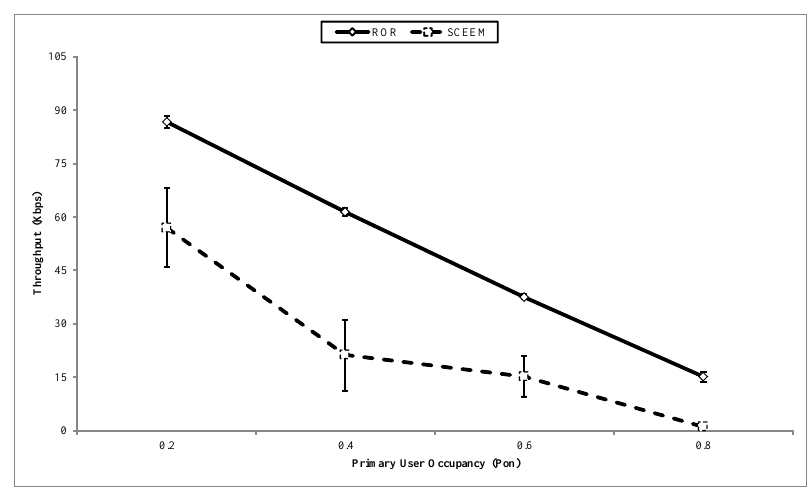
Figure 14. Throughput vs . primary user (PU)